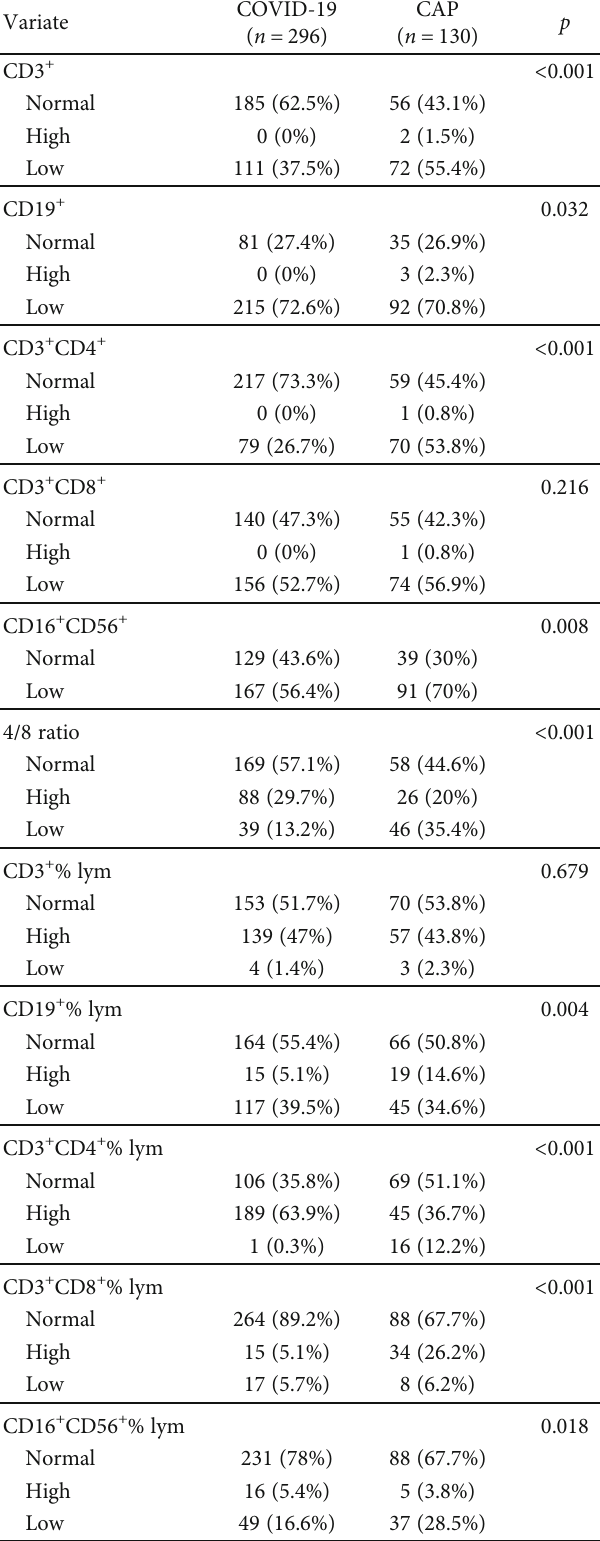
Table 2: Abnormal laboratory results for COVID-19 patients and CAP patients.